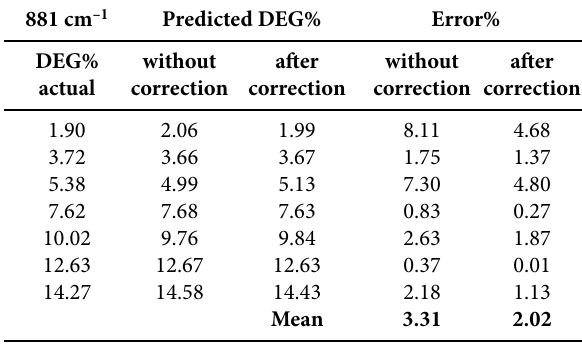
Table 1: Actual and predicted DEG% in Hederal and associated er- rors from IR absorbance at 881 cm –1 and 1083 cm –1 . 881 cm –1